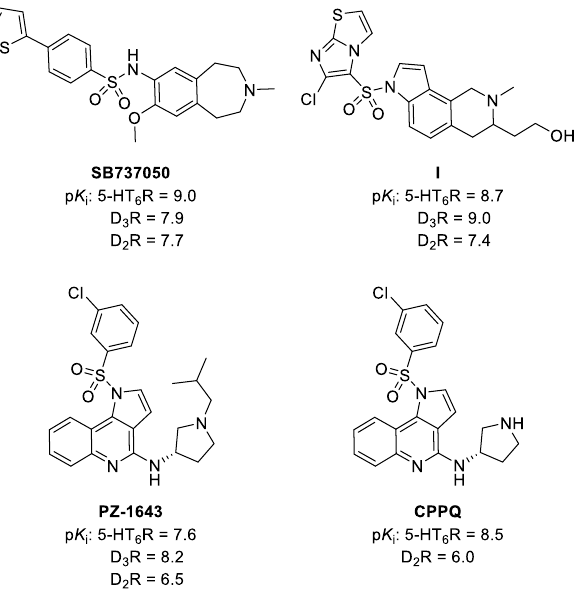
Figure 1. Structures of dual-acting 5-HT 6 /D 3 Rs antagonists and 5-HT 6 R antagonist CPPQ.